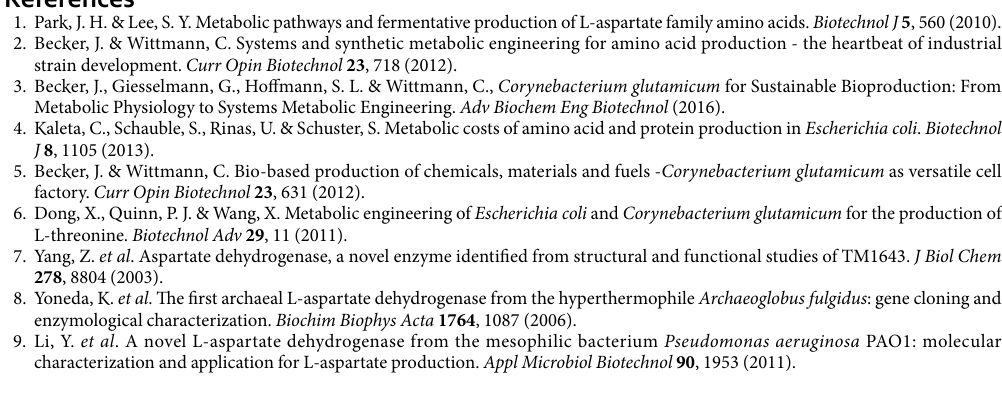
7 SCientifiC REpoRTS | 7: 7881 | DOI:10.1038/s41598-017-05522-7